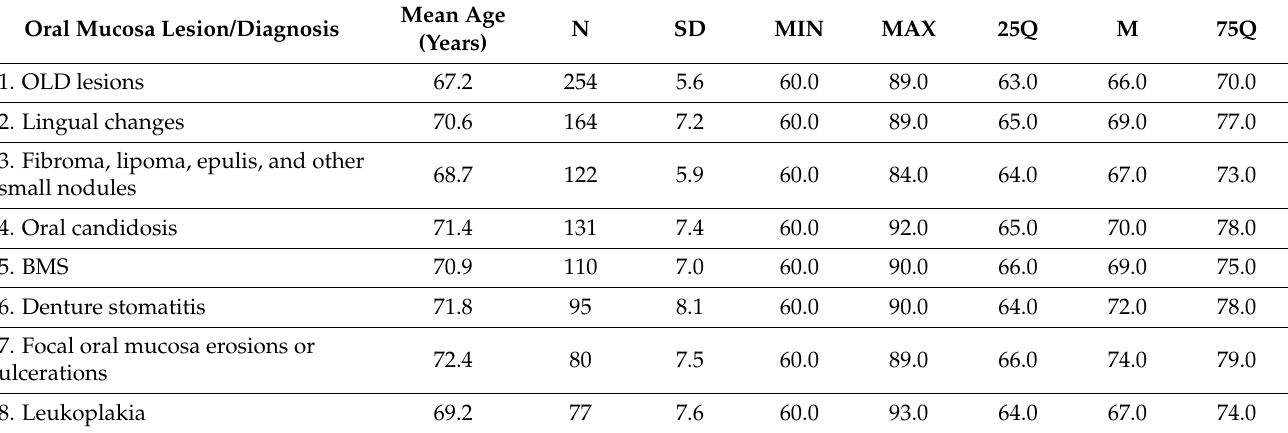
Table 3. The median and mean ages of patients with oral mucosa